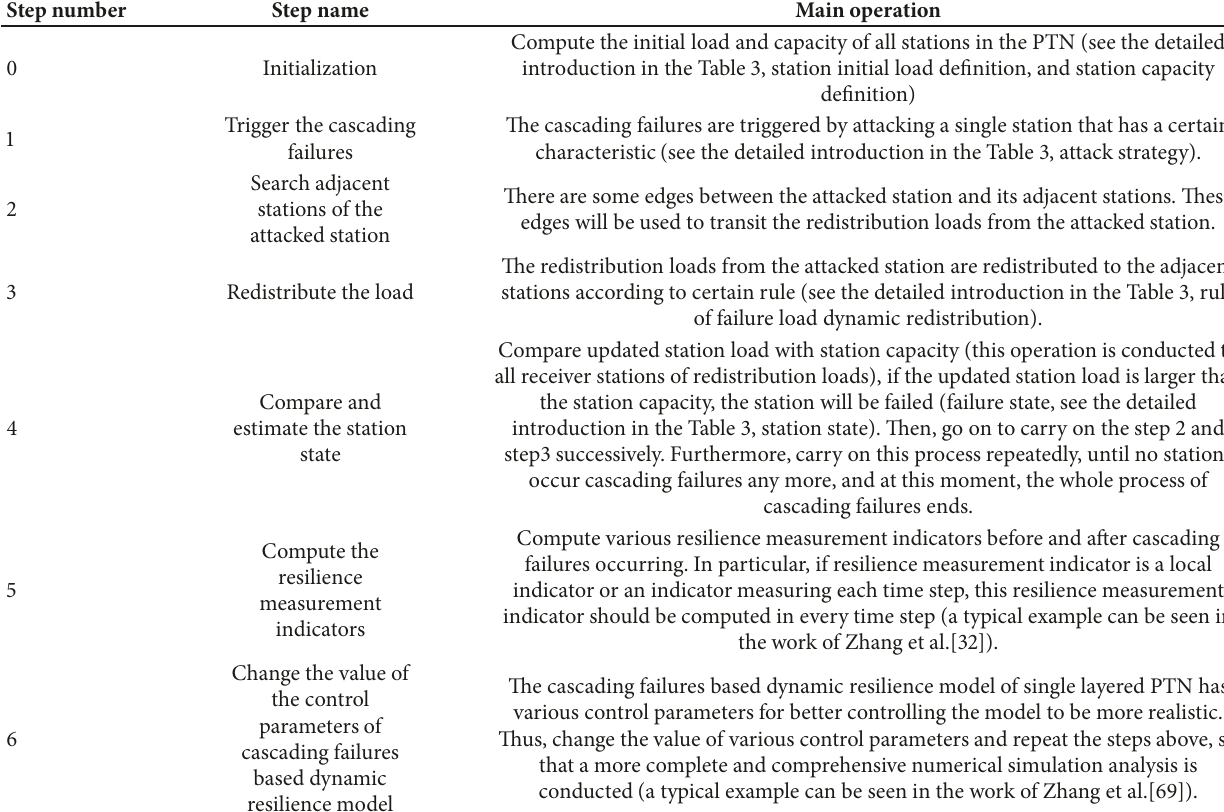
Table 4: Steps of numerical simulation analysis of dynamic resilience of single layered